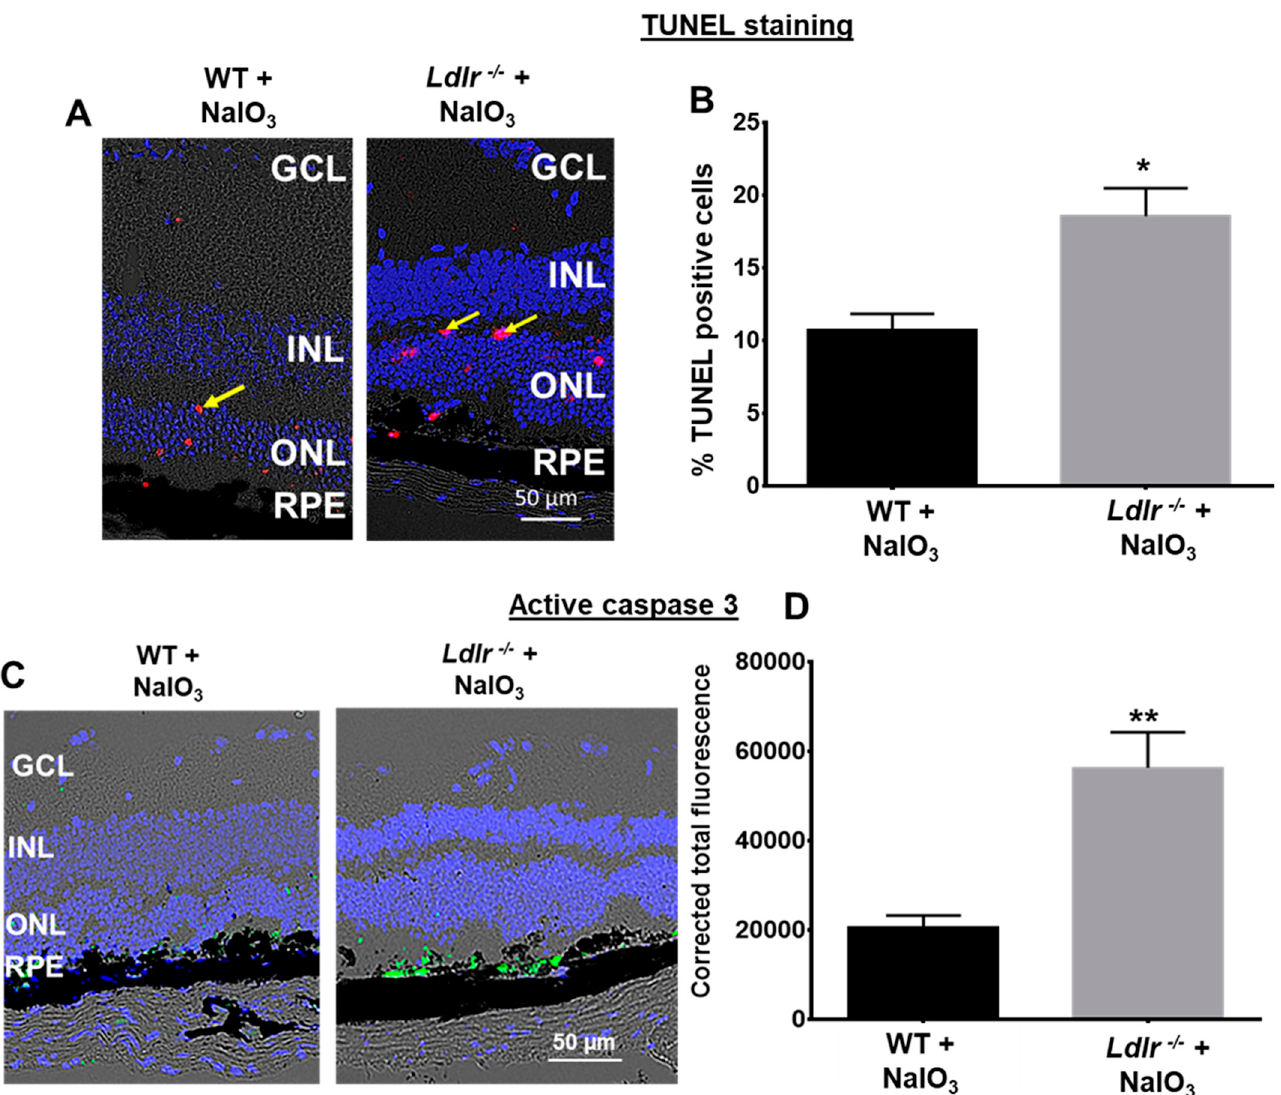
Figure 6. TUNEL and caspase activation in retina 7 days after a single NaIO 3 (20mg/kg) treatment in C57BL6 (WT) and Ldlr − / − mice. ( A ). Apoptosis was assessed by TUNEL assay. Apoptotic cells are observed in the ONL, RPE, and choroid. ( B ). Total number of TUNEL positive cells. The percentage of TUNEL positive cells in the Ldlr − / − + NaIO 3 group was significantly increased. No cell death was observed in PBS-treated WT or Ldlr − / − (not shown). Data are shown as mean ± SEM ( n = 10, * p < 0.0027). ( C ) Activation of caspase-3 in NaIO 3 challenged mouse retina. ( D ). Quantification revealed that caspase-3 activation was significantly higher in NaIO 3 -treated Ldlr − / − mice when compared with the corresponding stressed WT mice (mean ± SEM, n = 6) ** p <